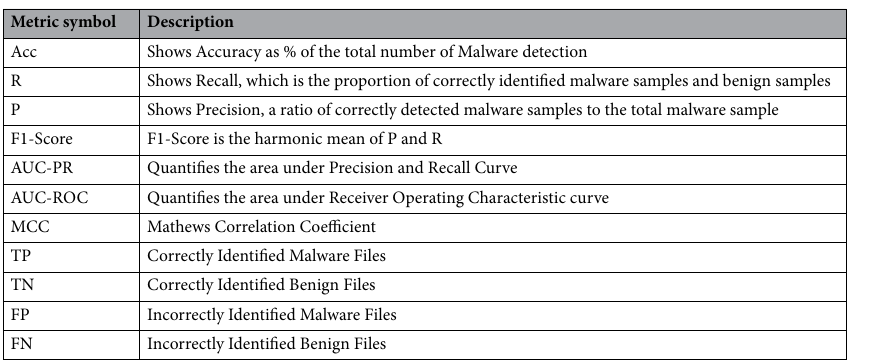
Table 1. Details of performance